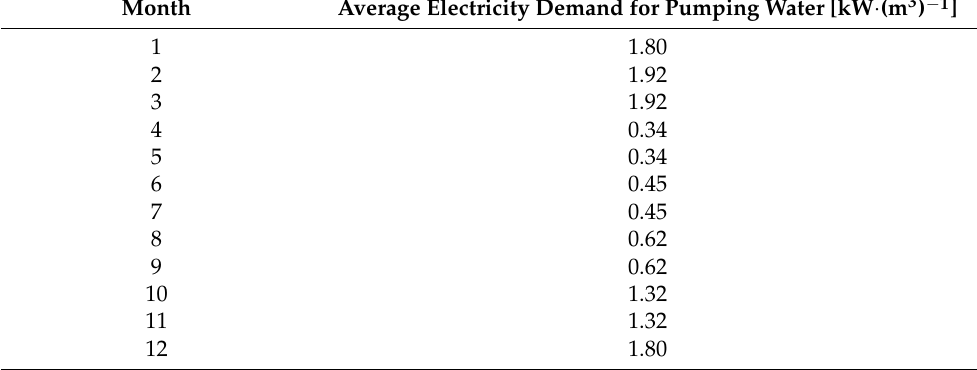
Table 1. Average electricity demand for pumping